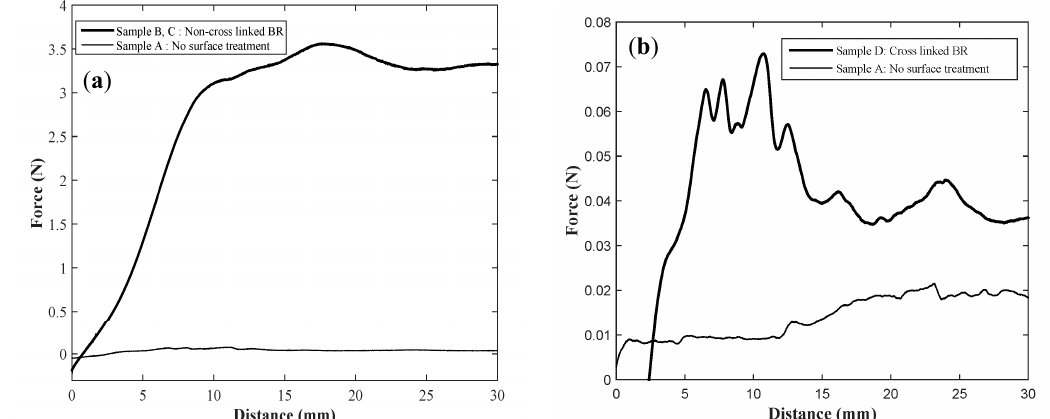
Figure 1. Comparison of forces measured to peel PDMS from the PI show in ( a ) between non- cross linked BR sample and no surface treatment sample, and in ( b ) between cross linked BR and no treatment PI surface. The negative forces in the graphs represent the stiffness of the PDMS which pushes against the load cell in the beginning before giving stable force